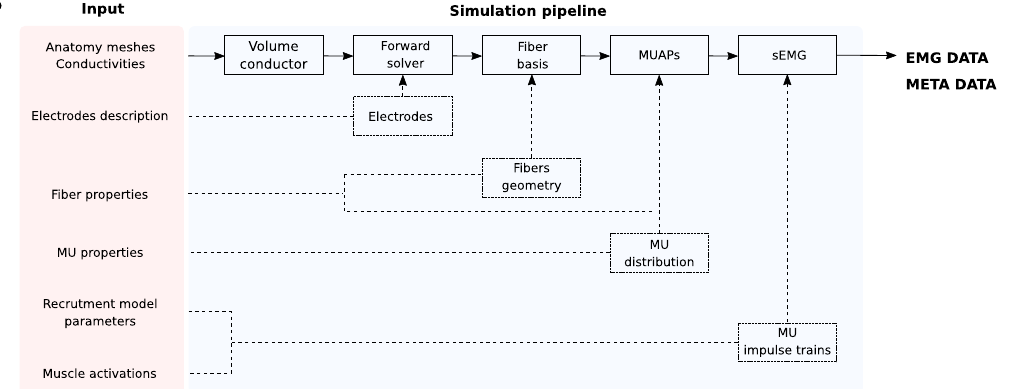
fi bres geometry and their physiological properties, motor unit (MU) distribution and their recruitment model, activation of individual muscles, etc. The main componentsofthesimulationpipelinearedescribedindetailsin ‘ Methods ’ section. Foragivensetoftheparameters,thesoftwareoutputstheresultingsimulatedEMG data as well as all the metadata of the simulation (e.g. individual motor unit action potentials